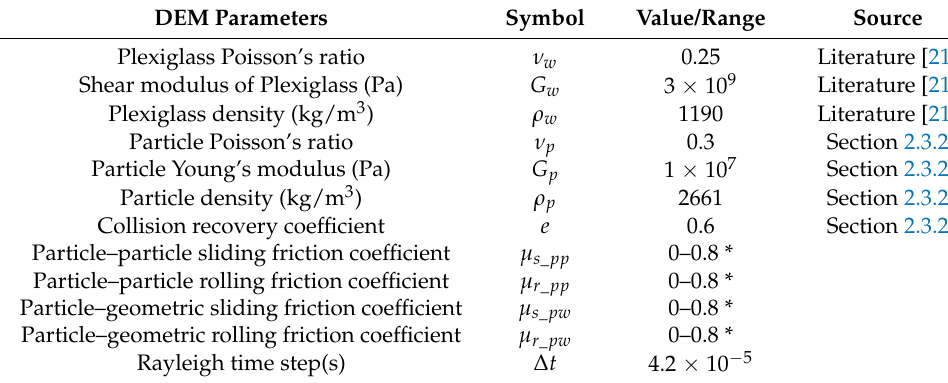
Table 6. DEM parameters, relevant symbols, and values/ranges studied in this paper; parameters to be calibrated are set as ranges, which are denoted by